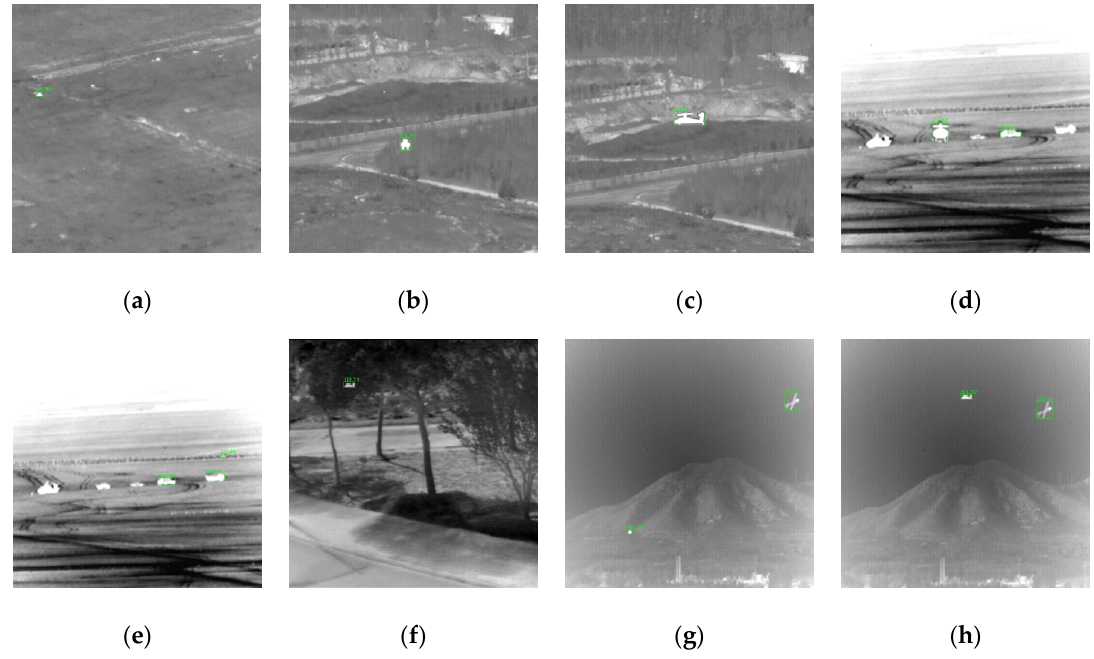
Figure 10. Some of the recognition results. The target is in the grassland ( a ), road ( b ), ( c ), desert ( d ), ( e ), trees ( f ), and mountains ( g ), ( h ). In ( d ), ( e ), ( g ), and ( h ), the original armored vehicles and aircraft in the scene were also recognized.